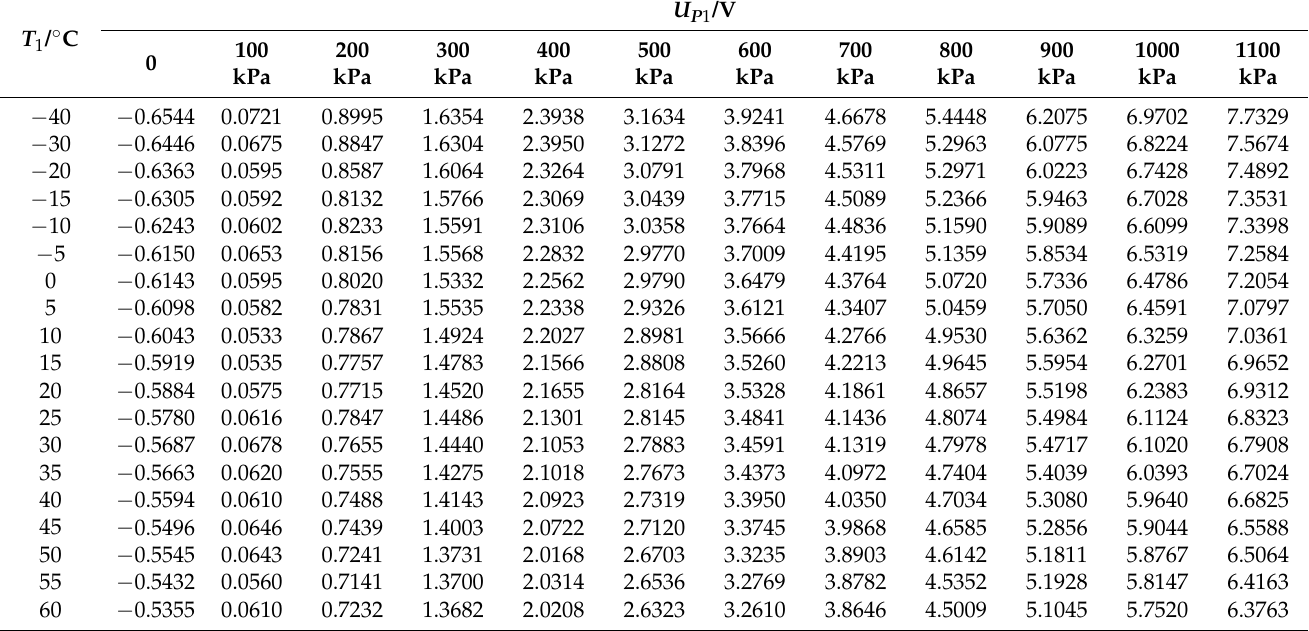
Table 1. Calibration data at full